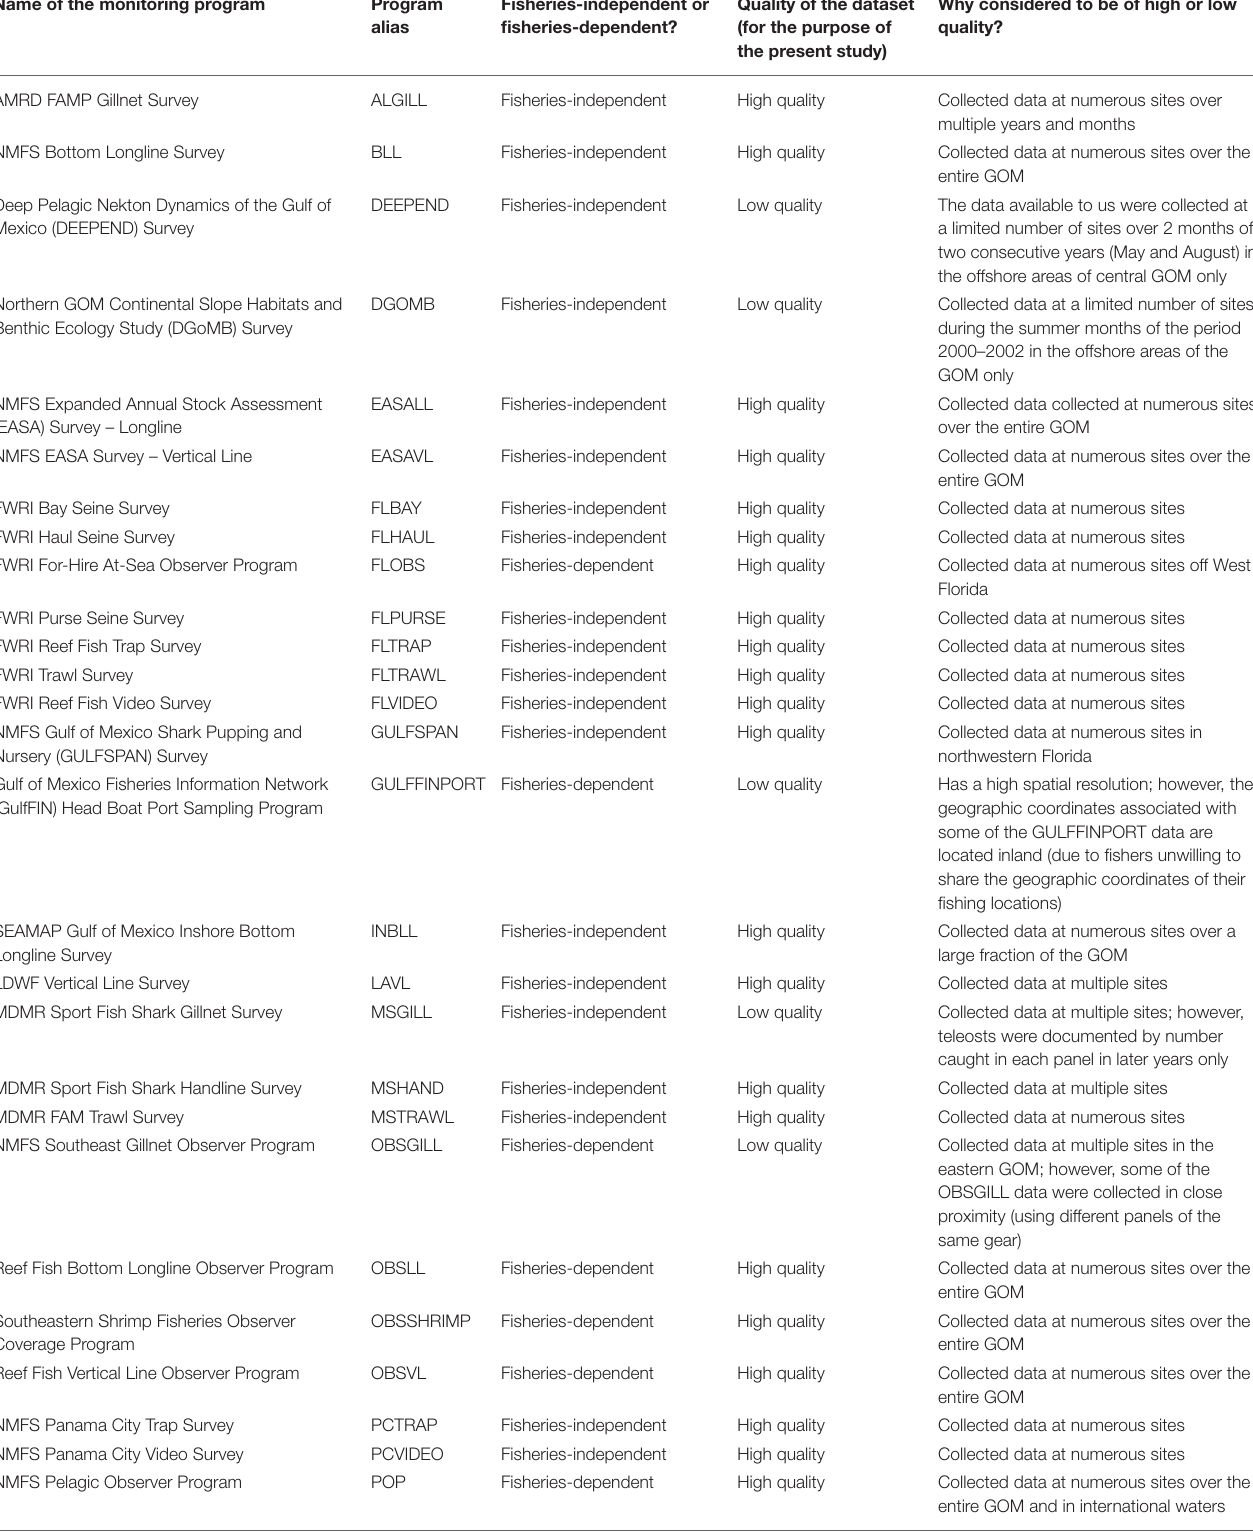
TABLE 2 | Monitoring programs comprising the large monitoring database for the U.S. Gulf of Mexico